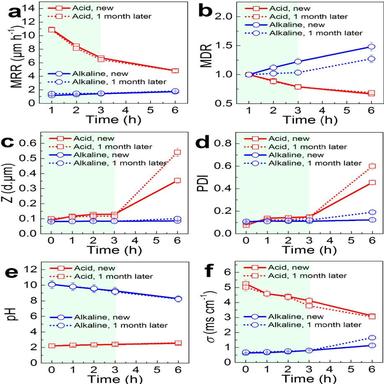
Performance evaluations for both acid and alkaline SiO2 slurries within 6 h (h) polishing: (a) MRR, (b) MDR, (c) Z, (d) PDI, (e) pH, and (f) σ. The performance of slurries standing for 1 month are also provided for comparison.